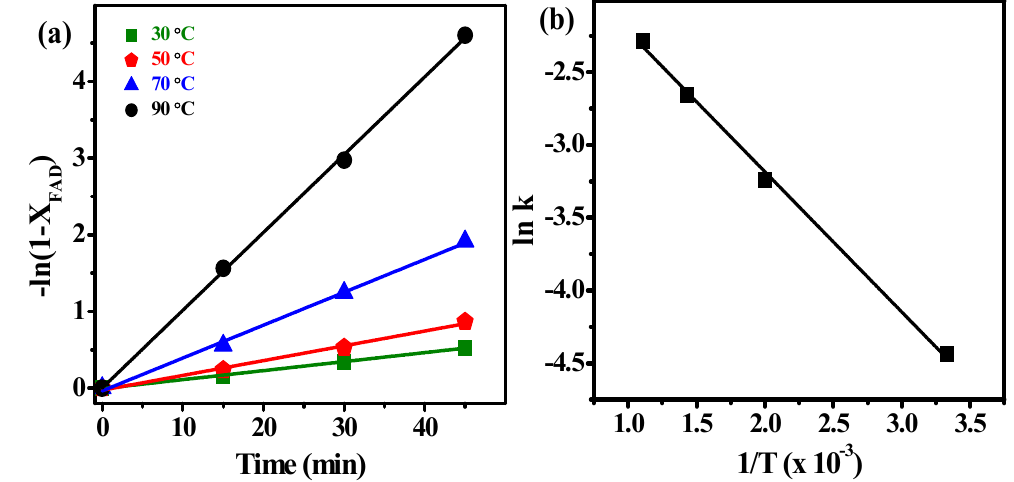
Figure 6. ( a ) Plot of − ln(1 − X FAD ) versus kt at di ff erent reaction temperatures for the Figure 6. (a) Plot of –ln(1 – X FAD ) versus kt at different reaction temperatures for the 2-Zn / CaO-400-catalyzed aminolysis of JO. ( b ) The Arrhenius equation curve for the aminolysis of JO. 2-Zn/CaO-400-catalyzed aminolysis of JO. (b) The Arrhenius equation curve for the aminolysis of JO. Reaction conditions: diethanolamine / JO = 5:1 (m / m), catalyst amount = 4 wt%, temperature = 90 ◦ Reaction conditions: diethanolamine/JO = 5:1 (m/m), catalyst amount = 4 wt%, temperature = 90 °C.